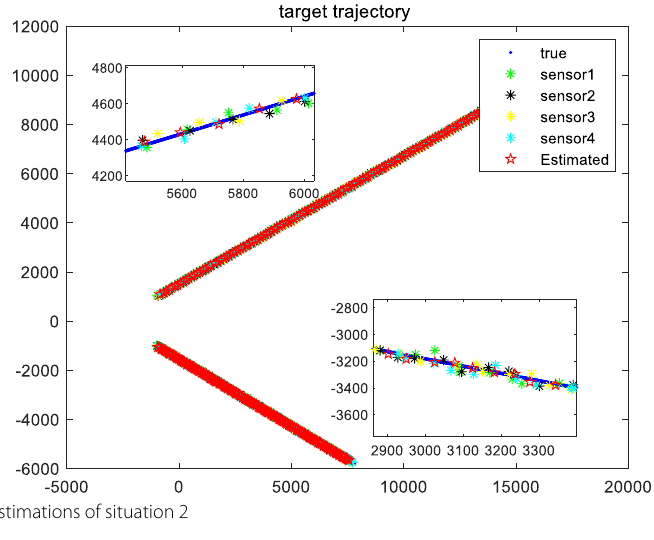
Fig. 7 The estimations of situation 2